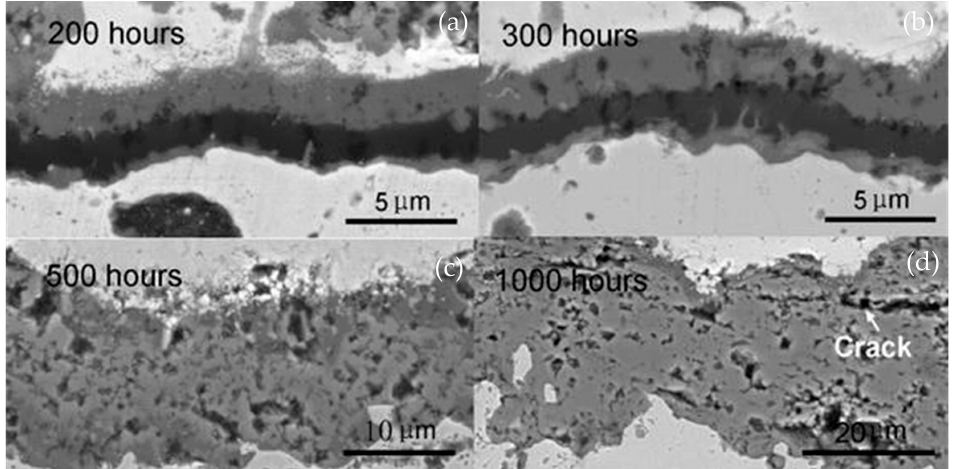
Figure 7. The oxidation results of CoNiCrAlY bond coat (BC) at 1100 °C for ( a ) 200 h; ( b ) 300 h; ( c ) 500 h and ( d ) 1000 h [78].